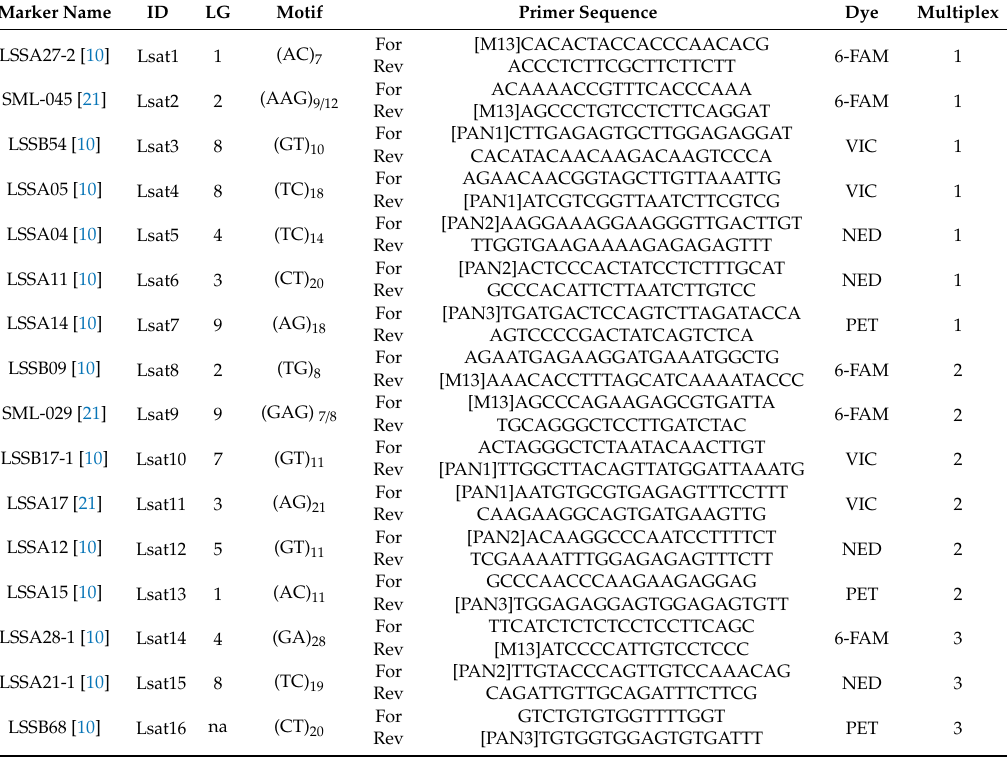
Table 1. Microsatellite loci information. For each primer pair, the original simple sequence repeat (SSR) name, ID used in this work, linkage group [10,21], SSR motif, primer sequences (PAN1, PAN2, PAN3, or M13 tails at the 5’ end are indicated in square brackets; for further details see Table S2), dye and the multiplex to which the SSR marker locus belongs is